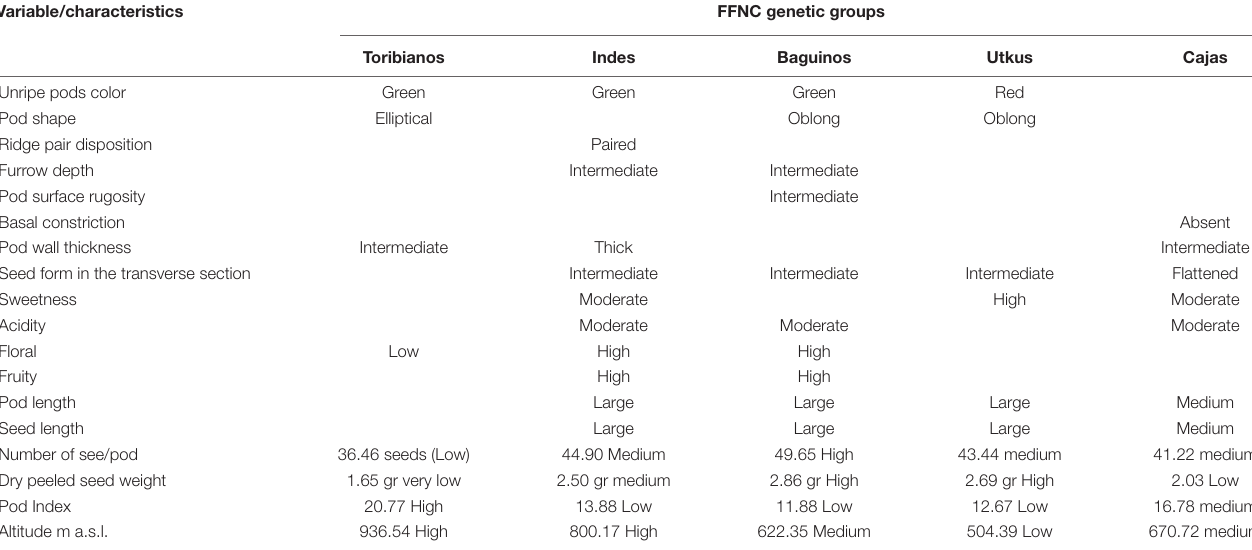
TABLE 3 | Differential characteristics of the genetic groups of FFNC from the northeastern region of